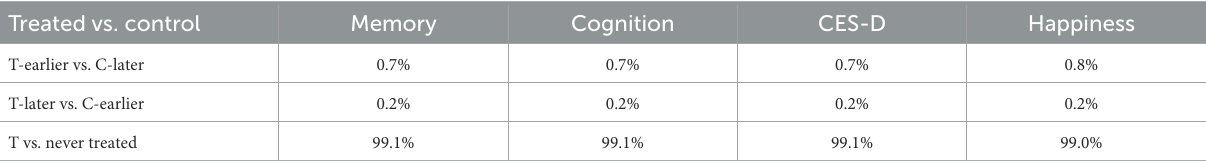
TABLE 7 The Goodman-Bacon decomposition. Treated vs. control